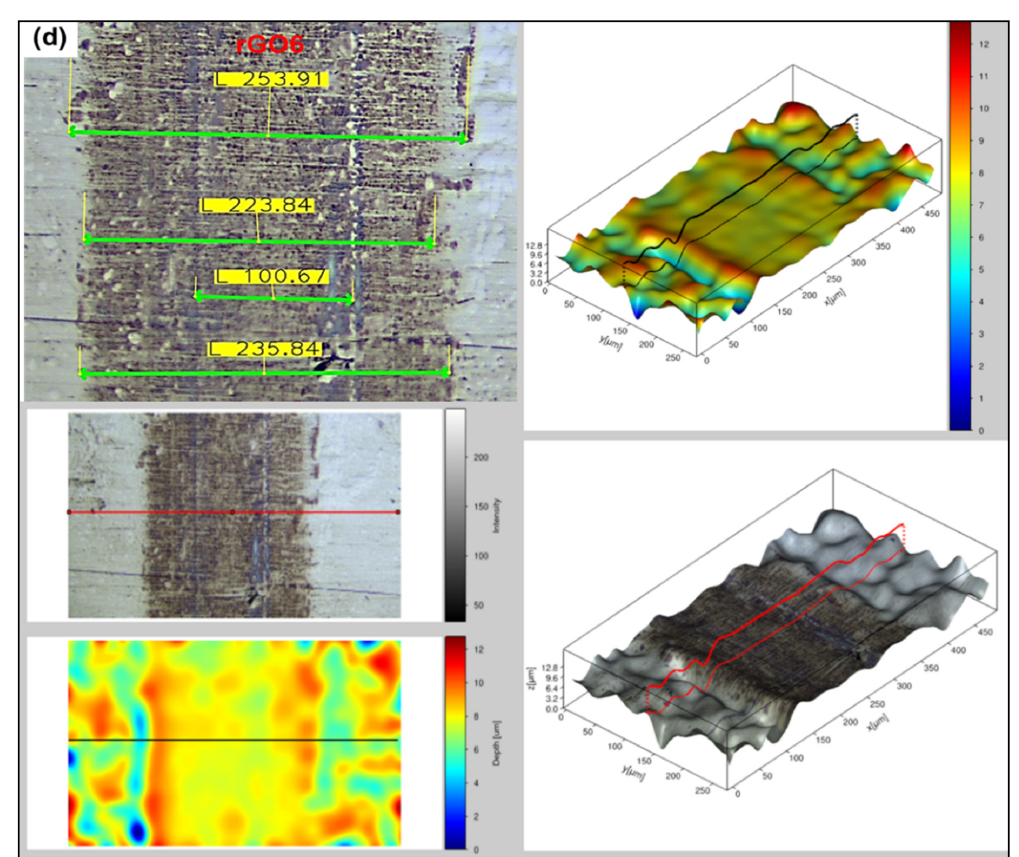
Figure 5. Optical microscopy images of the rubbing balls ( a , b ) and blocks ( c , d ) taken after the first measurement, to investigate the wear scar and roughness after testing ( a , c ) 5W-40 engine oil and ( b , d ) rGO6 sample. SEM images (Figure 6) supported by energy-dispersive X-ray spectroscopy (EDS)